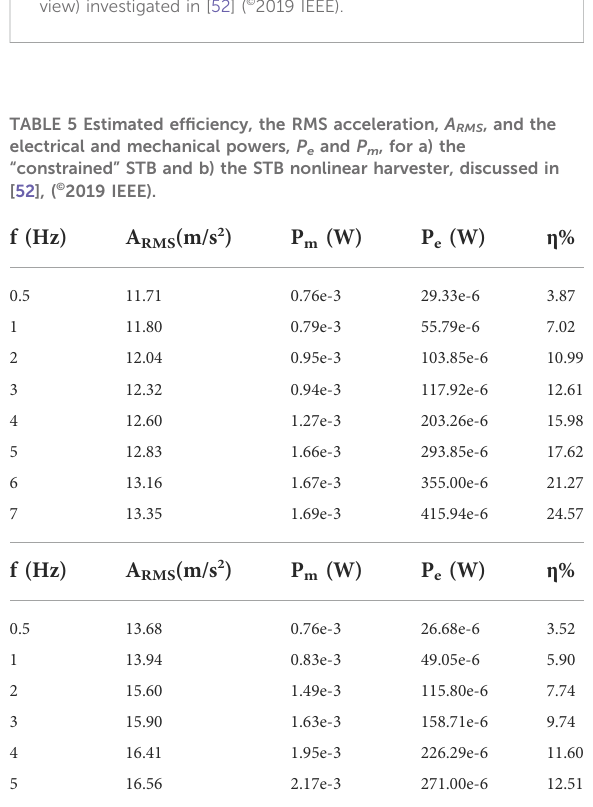
FIGURE 3 Schematization of the “ constrained ” bistable STB EH (top view) investigated in [52] ( © 2019 IEEE).